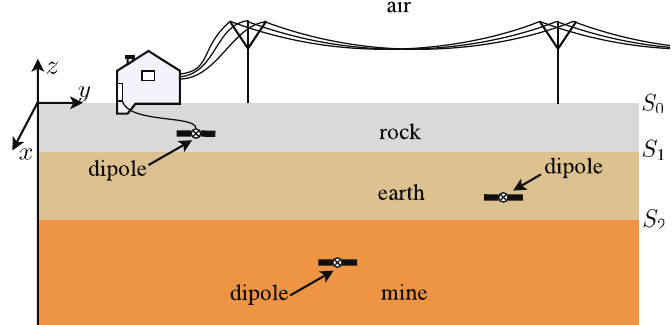
Figure 5. Air–rock–earth–mine layered media structure.